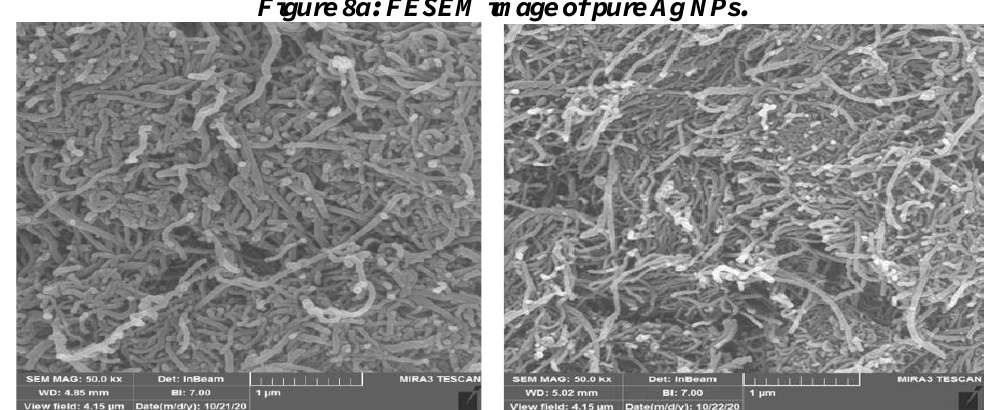
Figure 8a: FESEM image of pure Ag NPs.